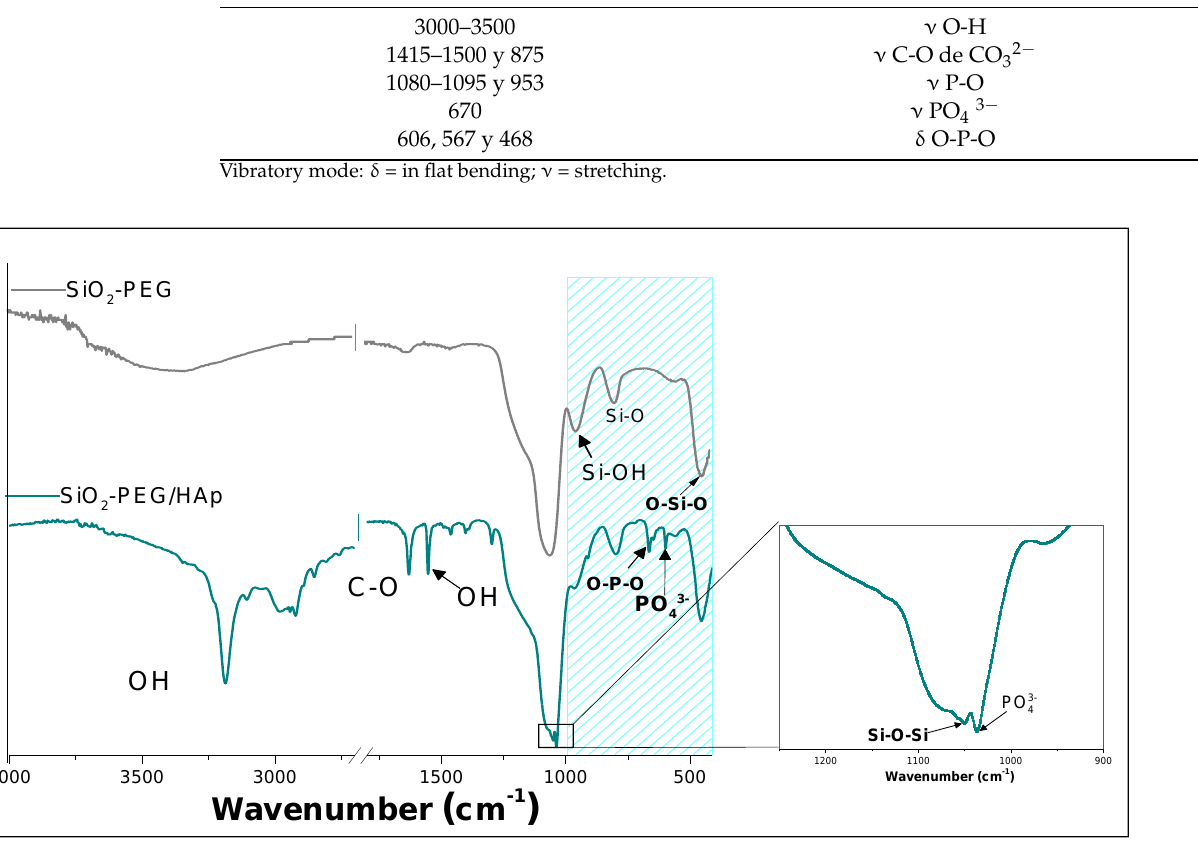
Figure 5. X-ray diffractogram of the SiO 2 -PEG before and after being submerged in the simulated body fluid (SBF) solution for 21 days. Figure 6 shows the SEM and TEM micrograph for SiO 2 -PEG/HAp. Various groups of aggregates were observed, wrapped in a continuous layer of HAp (Figure 6a,b), this wrap- per is favored by calcium and sodium ions, which allow nucleation of HAp crystals, as cited in the literature [7,10 – 12,38 – 40]. This nucleation and growth of crystals was observed